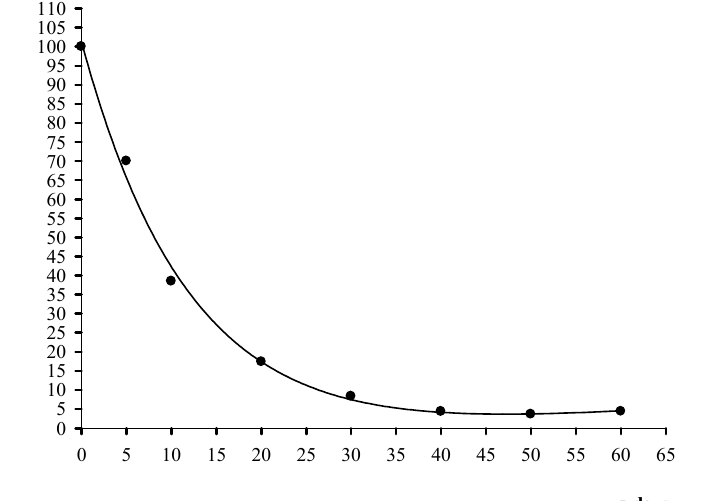
Figure 3. The history of steel grade St3 (sample No. 1) corrosion rate in the NaCl-containing solution, determined by iron availability in the saline solution without agitation.